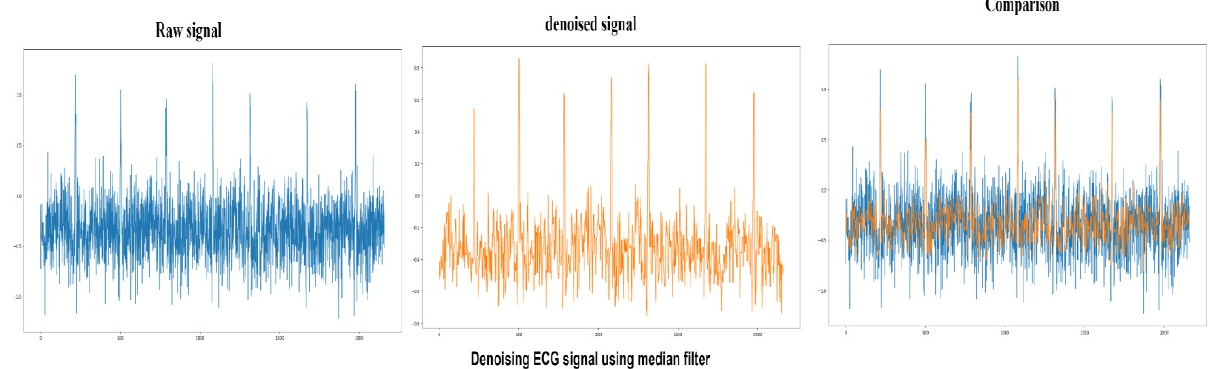
Figure 7. Raw ECG signal (Blue) denoising using median filter and comparison between denoised signal (Orange) and raw signal.